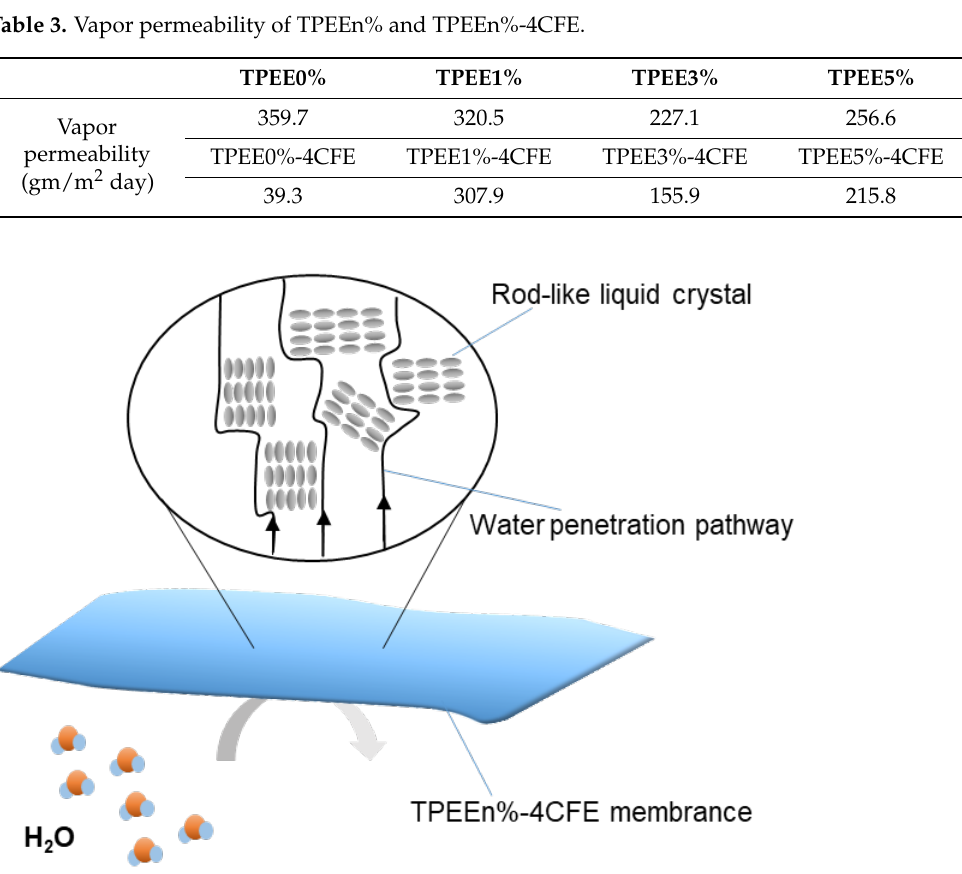
Figure 8. Schematic representation of water following a tortuous path through the TPEEn%-4CFE